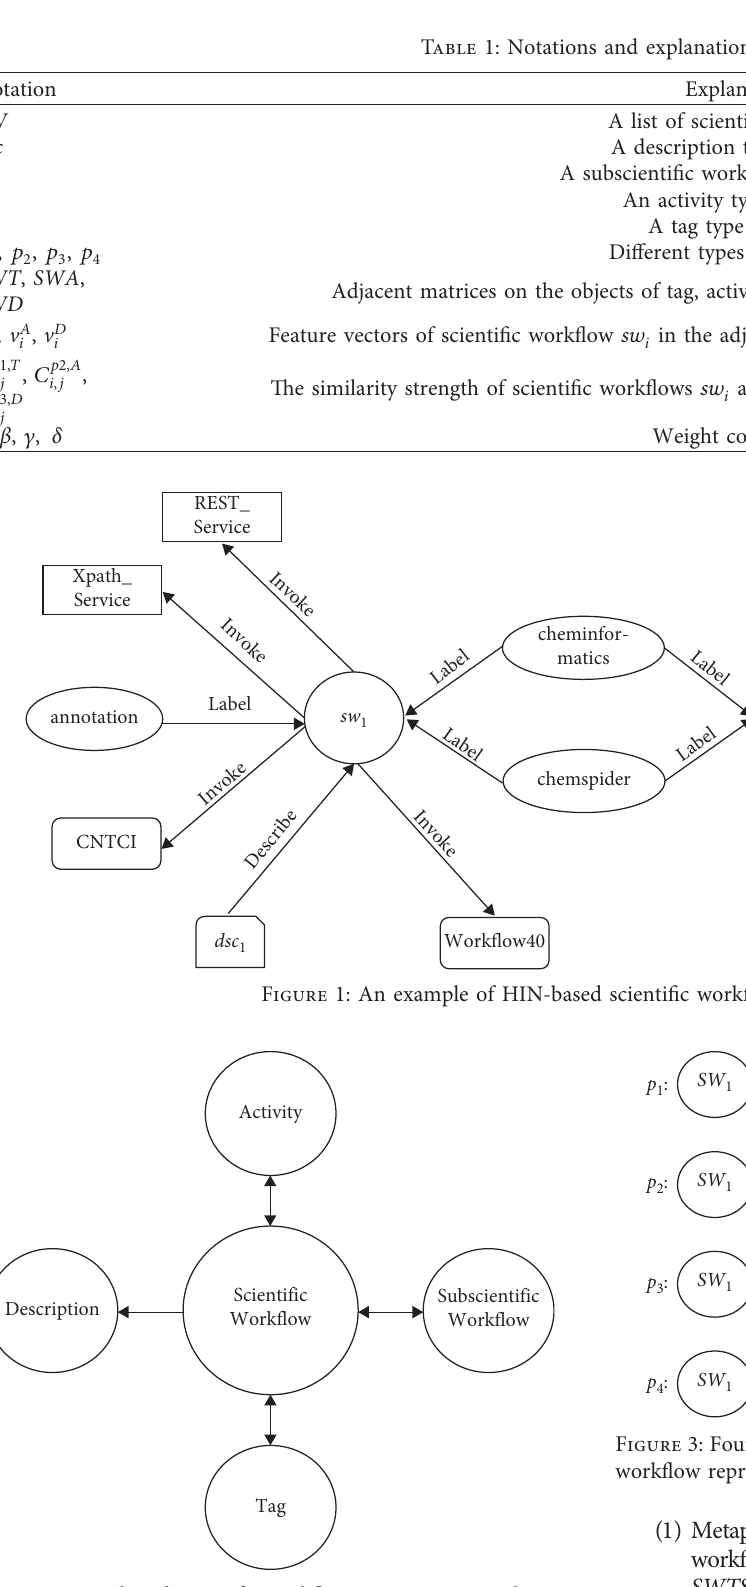
Figure 2: HIN-based scientific workflow representation schema.